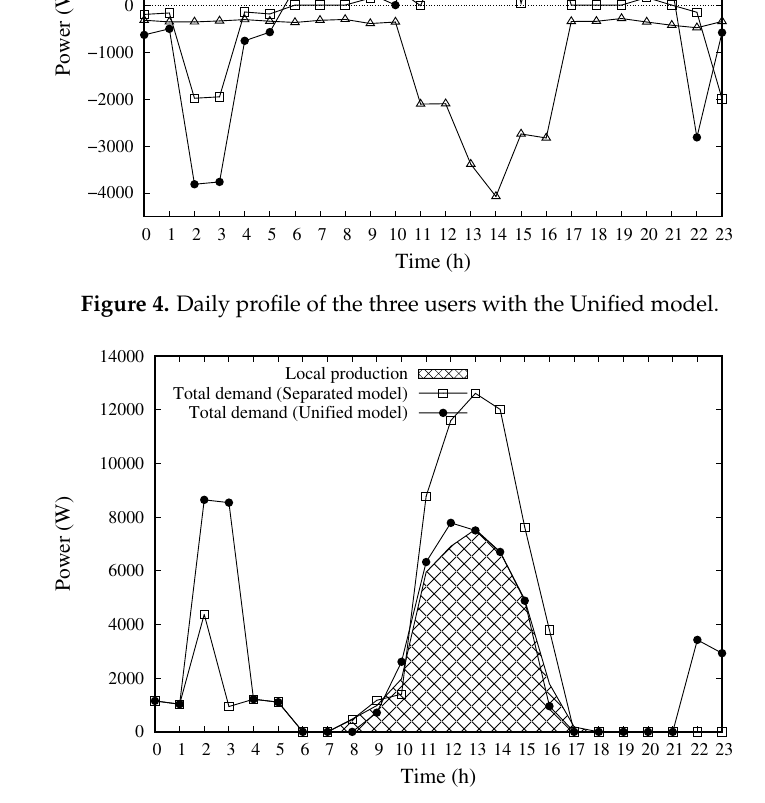
Figure 5. Local production and aggregated demand profile with Separated and Unified